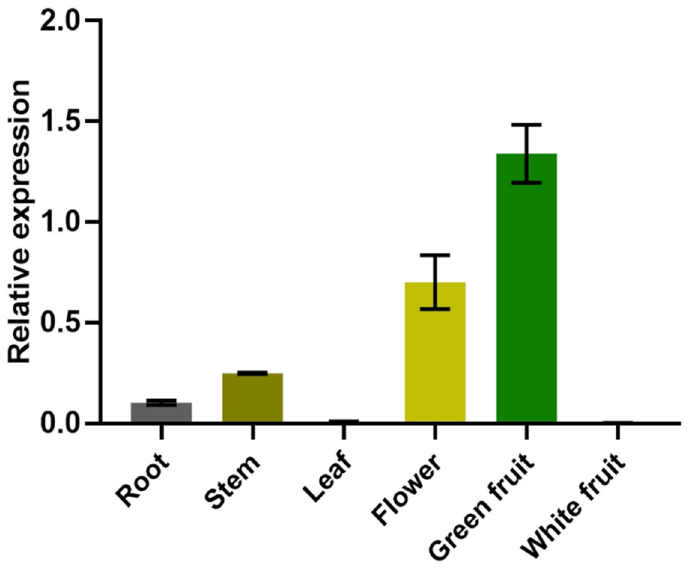
Figure 4. Analysis on tissue expression pattern of FvNST1b. Each column represented the mean of three replicates. Error bars on each column represented the standard error (S.E.) of three replicates. 2.4. Overexpression of FvNST1b Induces Ectopic Thickening of Secondary Walls in Various Tissues of A.